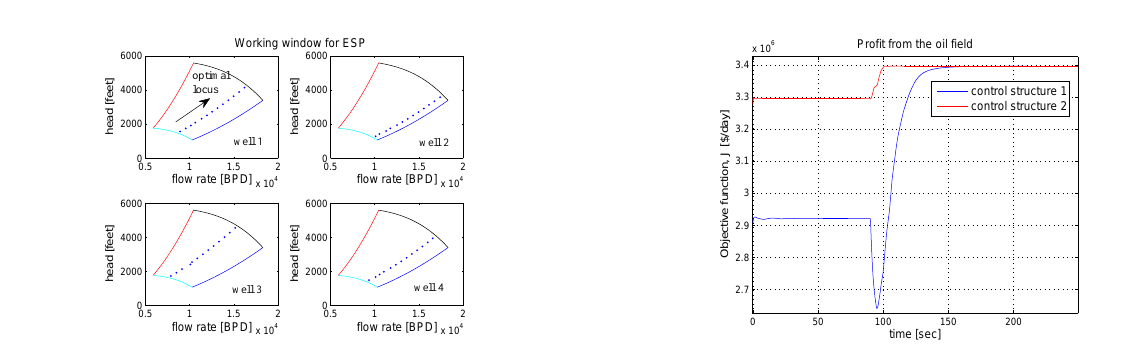
Figure 13: Optimal locus of the pump head inside its Figure 14: Profit from the oil field due to optimization operating window for different separator ca- pacities for case II trol structure fails to provide optimal results. In the second control structure, the hard equality constraint of u = 100% has to be satisfied. From case I, it was shown that for very low separator capacities ( ≤ 6500 m 3 /day ), the valves have to be closed below 100% to maintain the optimal flow rate calculated by the